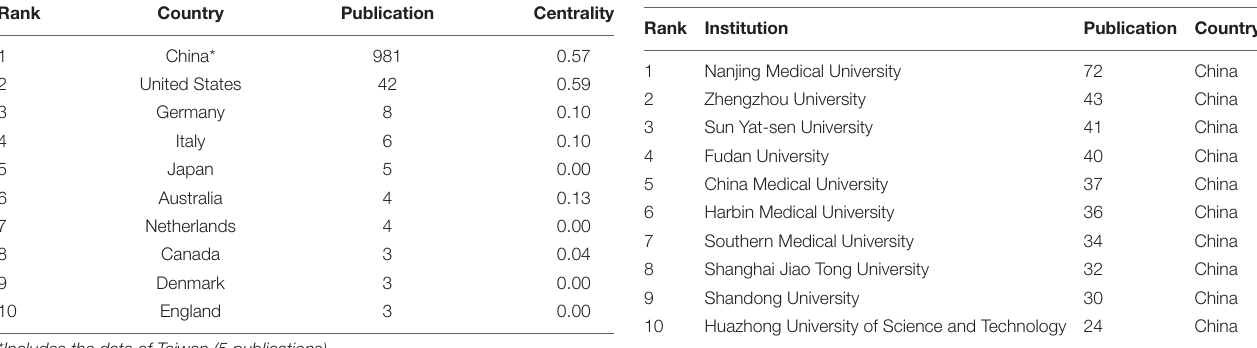
hepatocellular carcinoma by sponging miR-9 (Han et al., 2017).